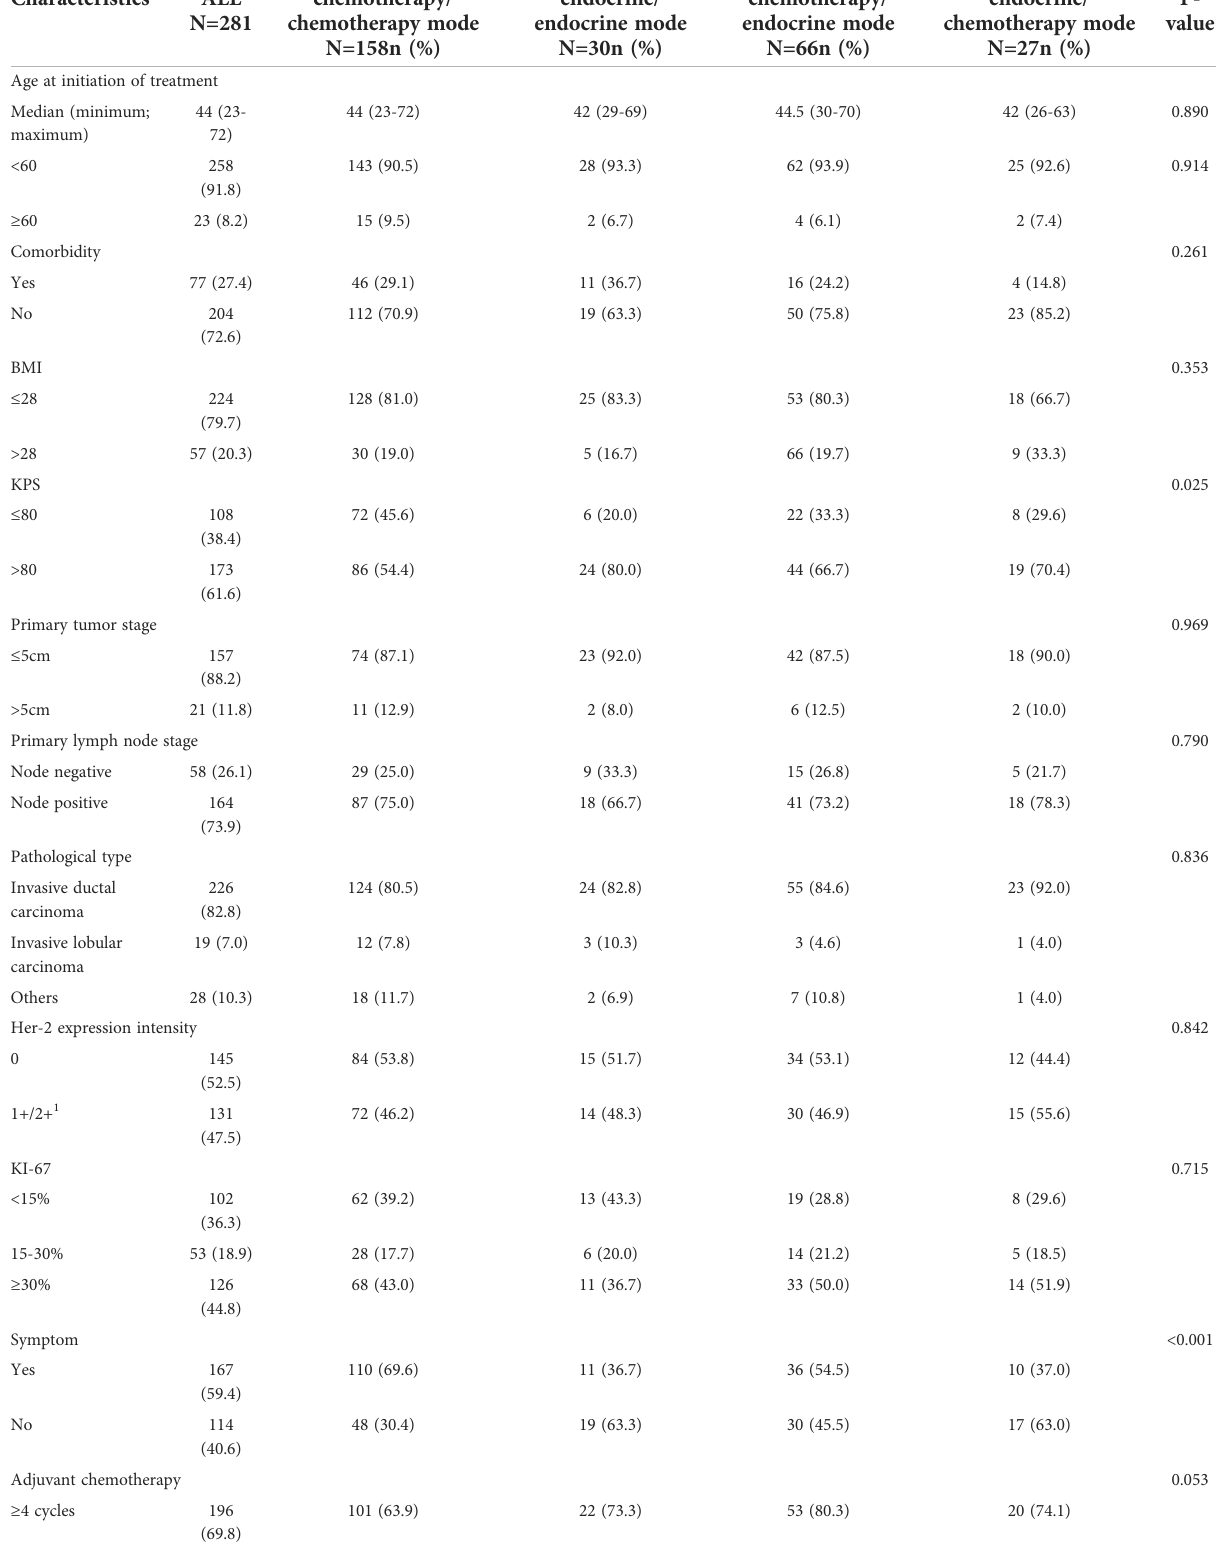
TABLE 1 Characteristics of HR+HER-2-MBC patients with different fi rst-line/second-line treatment modes.